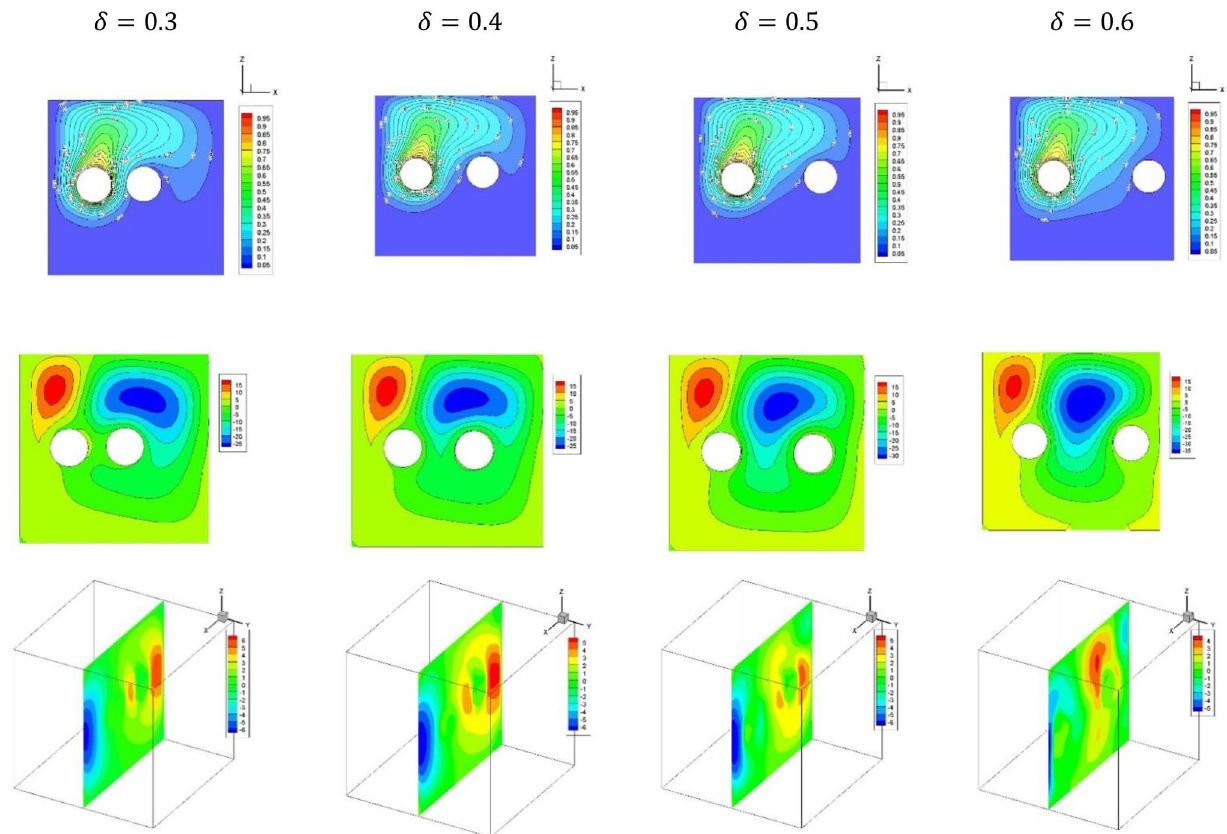
Figure 3. Plots of the temperature distributions, streamlines and dusty velocity W p for the variations of the δ in case of (η 1